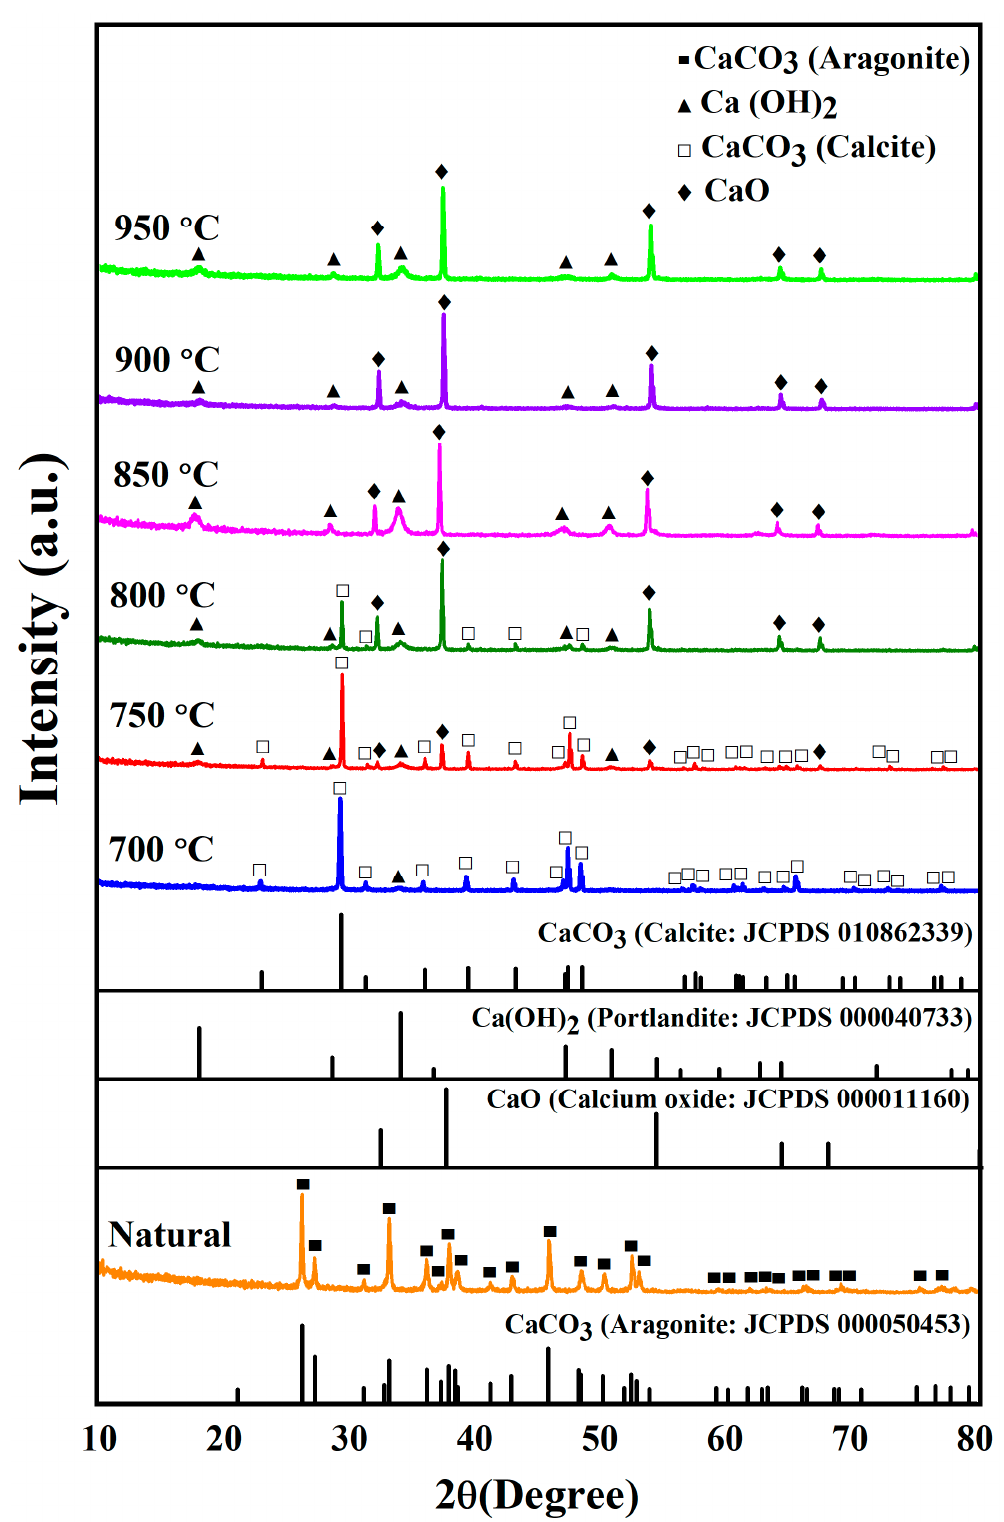
Figure 3. XRD patterns of uncalcined (natural) and calcined CS powders between 700 °C and 950 °C.